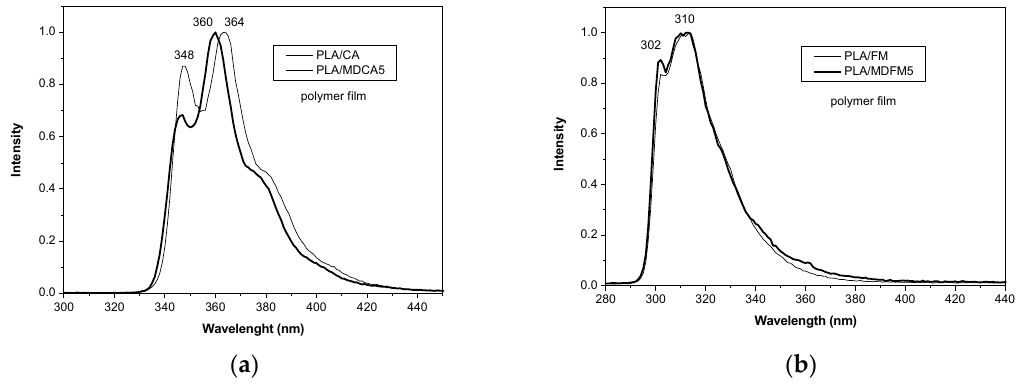
Figure 8. Fluorescence emission spectra of ( a ) PLA/CA and PLA/MDCA5, exc = 290 nm, and ( b ) PLA/FM and PLA/MDFM5, exc = 270 nm: Spectra are collected from polymer film and are normalized to emission maximum.